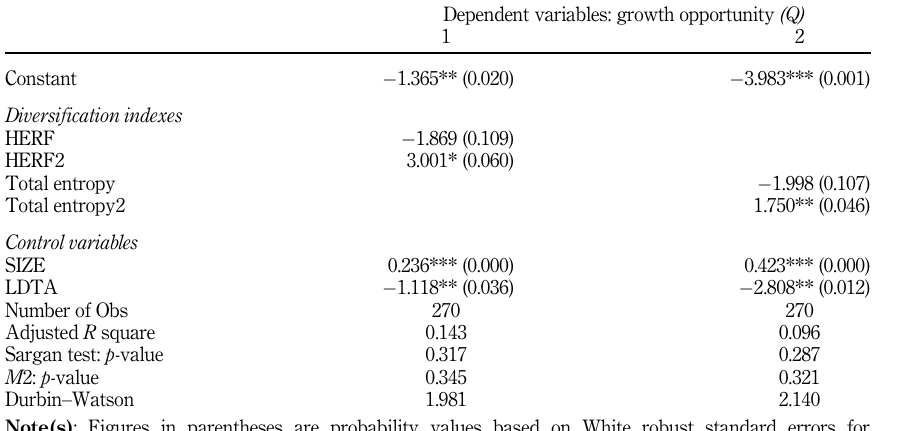
Table 2. Diversification